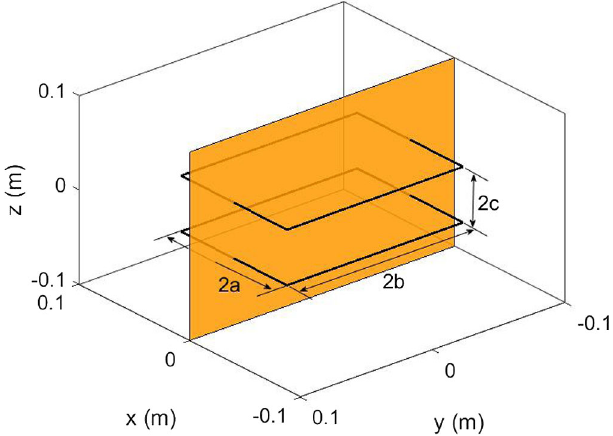
FIG. 26. Geometry of a pair of rectangular loops and the z - y plane.